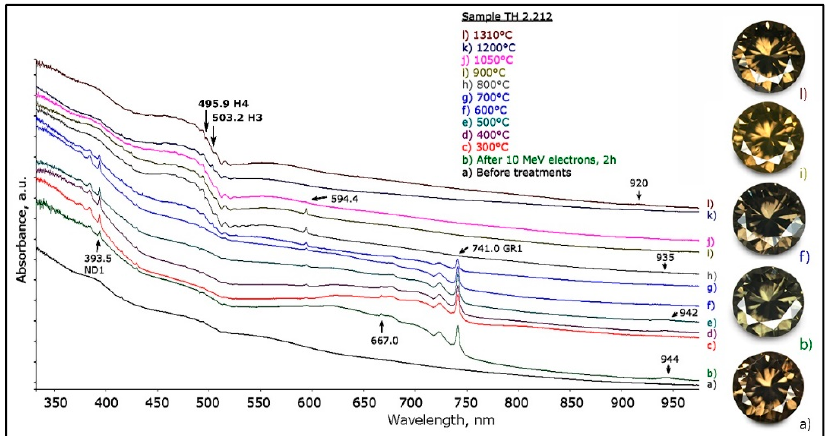
Figure 32. The evolution of the color and the UV-Vis-NIR spectra of a darker brown diamond (sample TH 2.212) after 2 h of 10 MeV electron irradiation and stepwise annealing from 300 °C to 1310 °C. The stone showed some color changes but remained essentially brown, because neither GR1 nor H4 or H3 had a strong enough influence on the distinct continuum absorption.